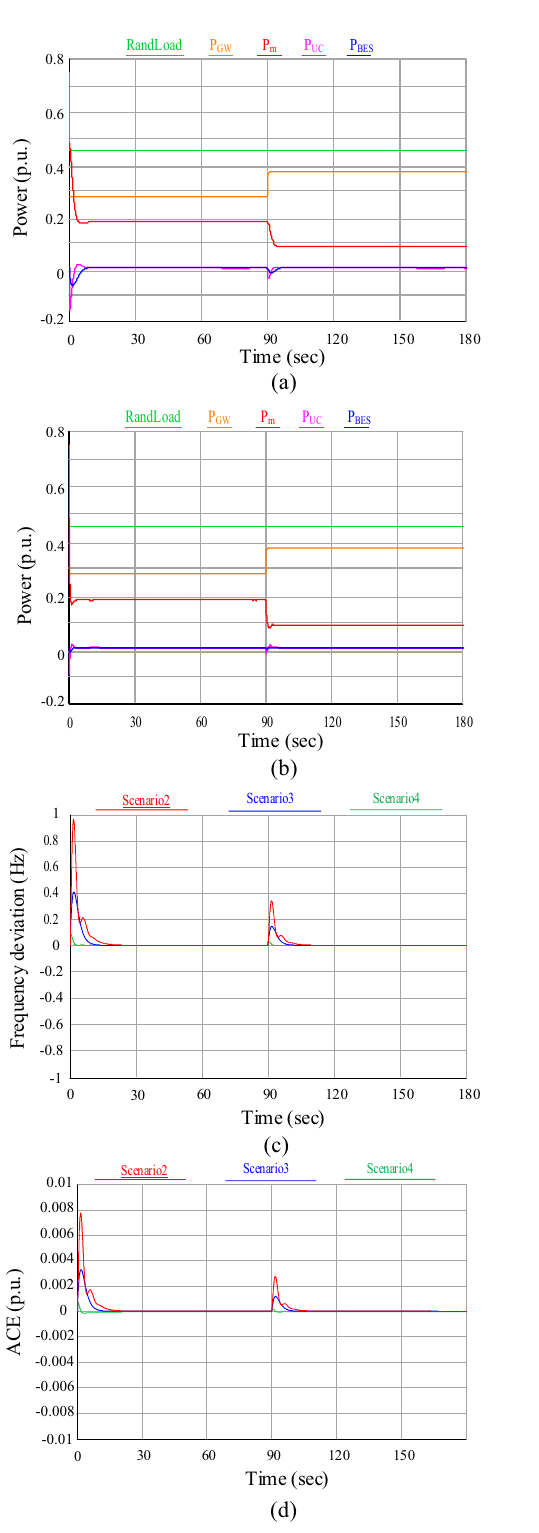
Fig. 8 Simulation results under step loads and wind speed, a power flow of scenario 3, b power flow of scenario 4, c system frequency deviation, d ACE deviation of area one